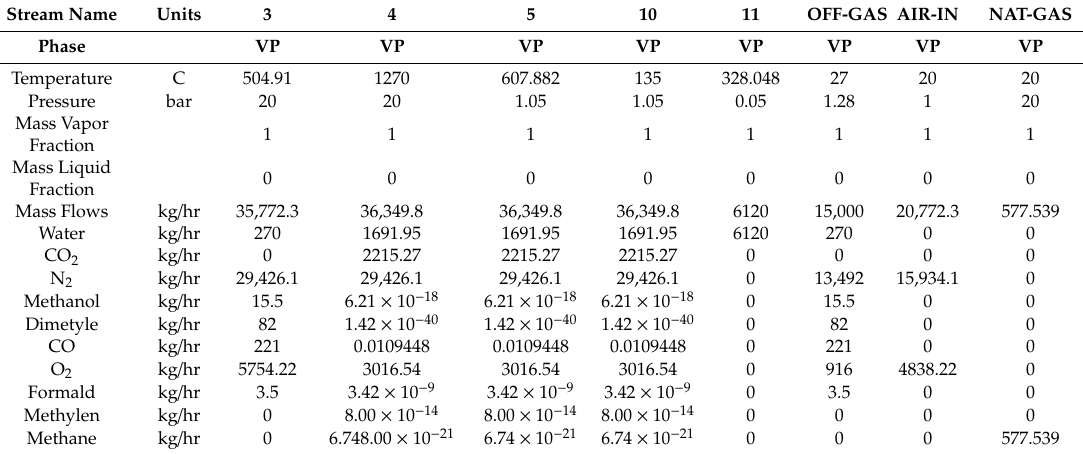
Table 4. Results of computer simulation of co-incineration of waste industrial gases from metal oxide catalyst formaldehyde production processes in combined-cycle gas turbines